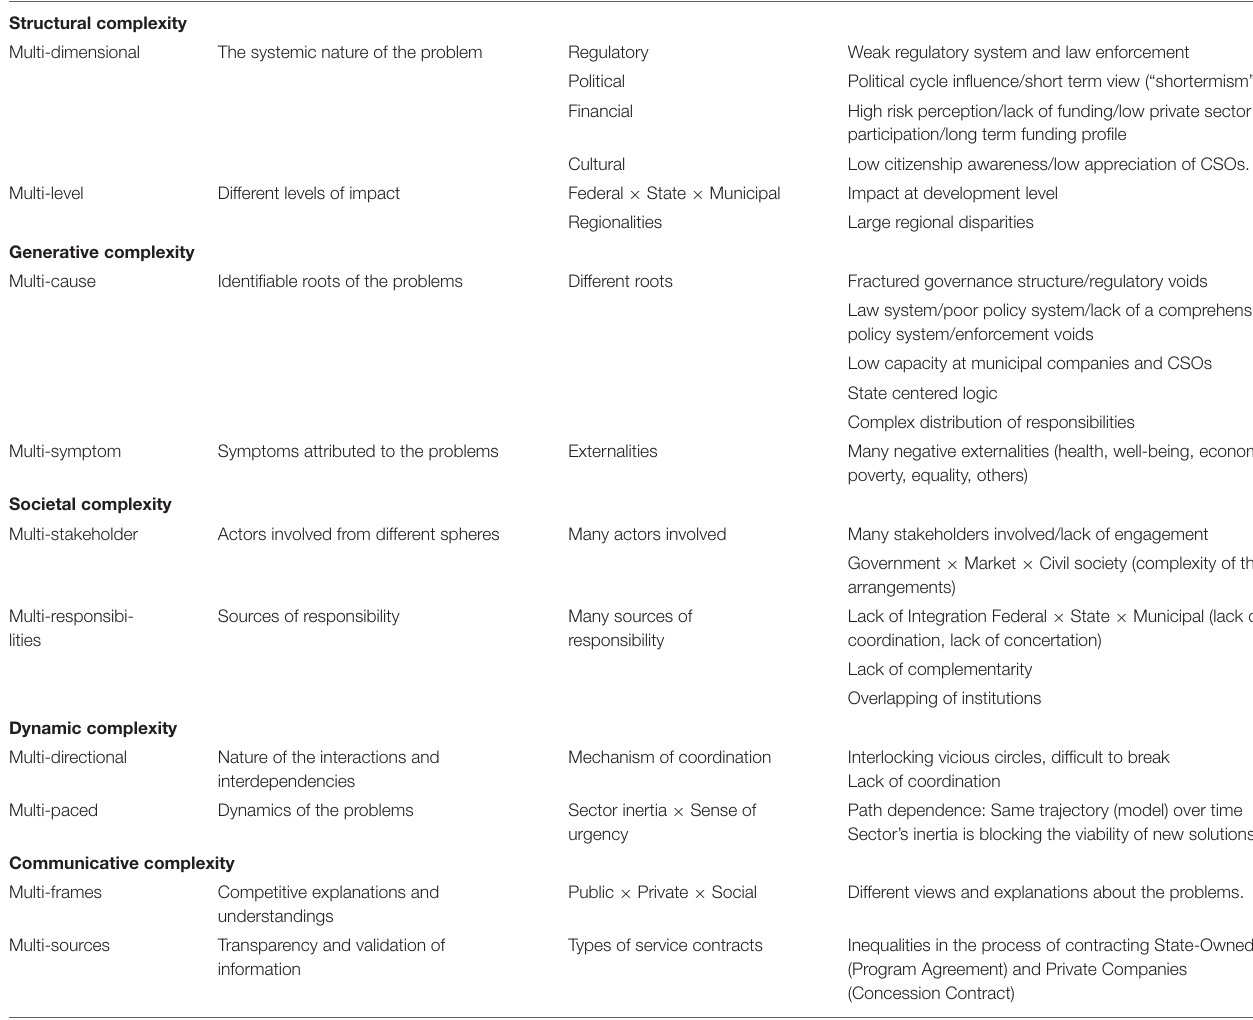
TABLE 6 | The wickedness of the Brazilian water and sanitation problems: dimensions of complexity. Structural